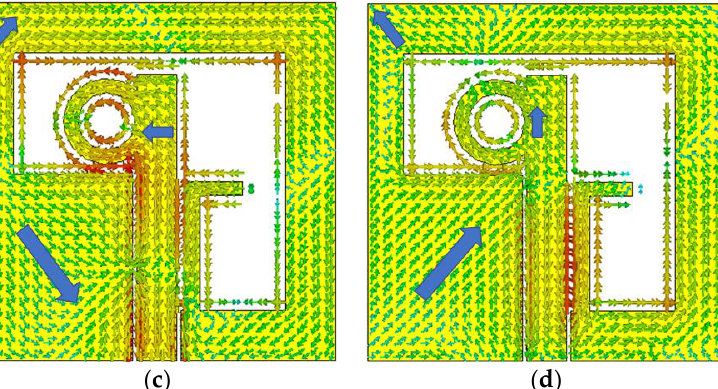
Figure 3. Surface current distribution of proposed antenna at 7.5 GHz. ( a ) 0° ( b ) 90° ( c ) 180° ( d ) 270°.